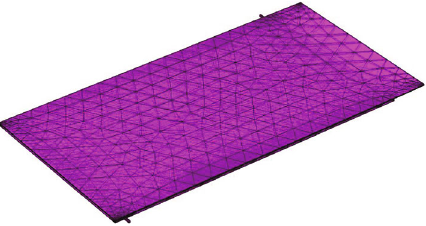
Figure 3: Finite element meshing of a PVT system. Table 3: Grid sensitivity check at G = 500 W/m 2 and V